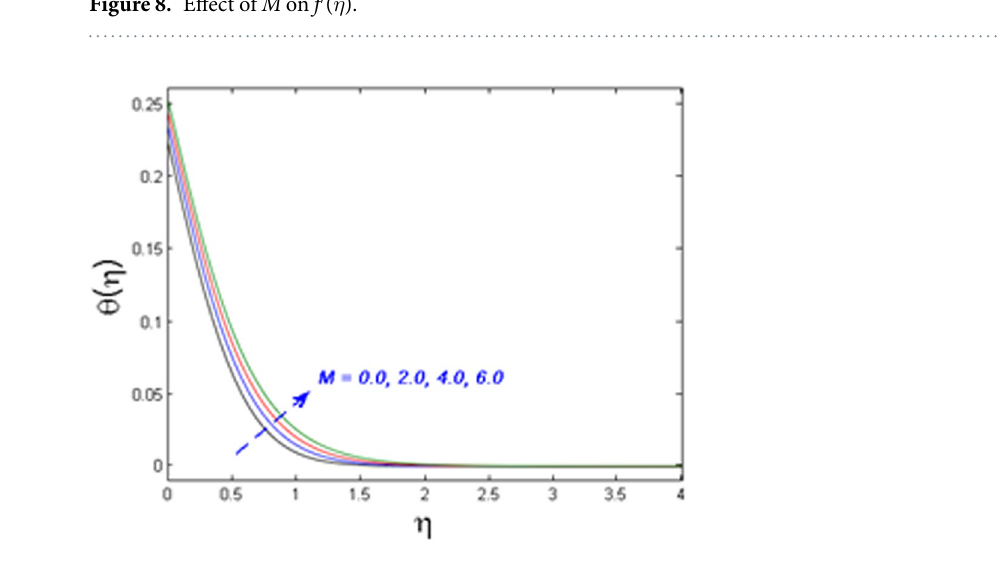
Figure 9. Effect of M on θ ( η